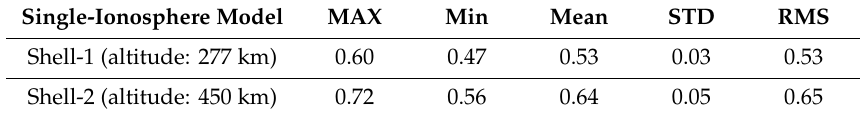
Table 2. Statistics of calculated acoustic wave velocity in di ff erent shell models (unit: km / s). Single-Ionosphere Model